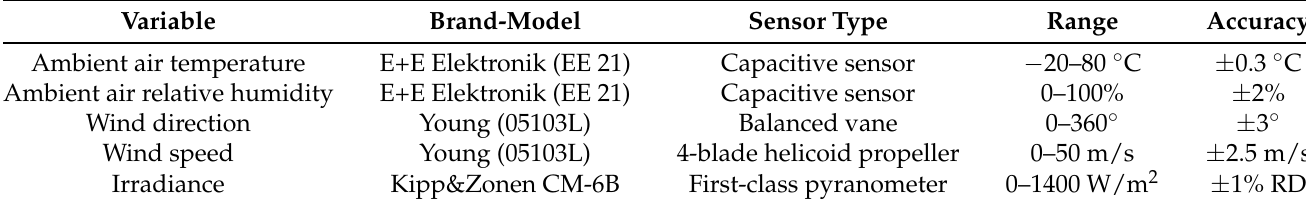
Figure 5. Experimental facility. ( a ) Front view. ( b ) Rear view. Reprinted from Ruiz et al. [20] with permission from Elsevier, 2020. Table 2. Measuring equipment used in the experimental